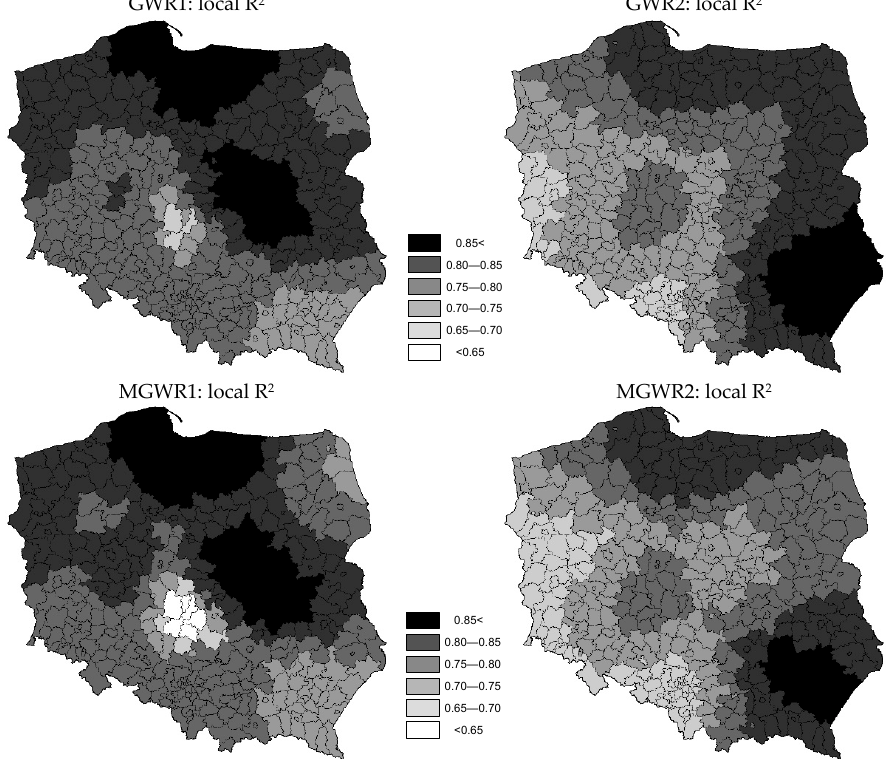
Figure 7. Local R 2 in the Geographically Weighted Regression (GWR) models. Source: own research. The GWR1 model, in which the average unit price, Y 1 , was the response variable, the local coefficient of determination indicates the best fit in the northern part of the country and in the Warsaw area. The lowest values were noted in the central part (near Ł ód ź ) and the south ‐ eastern part. In the case of the GWR2 model, the best fit was found in the south ‐ eastern part of Poland. MGWR models are characterised by a similar distribution of the local coefficient of determination.